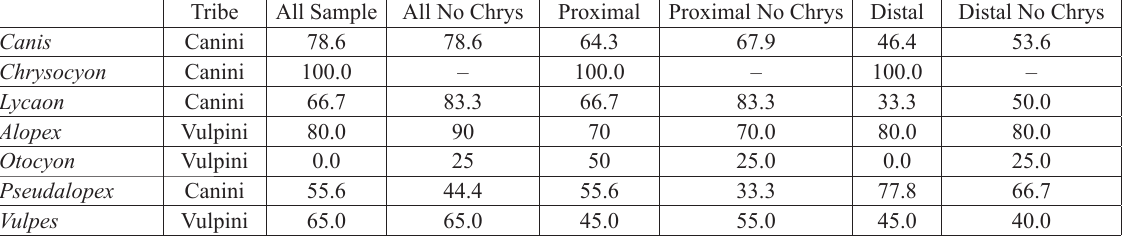
Table 4. Percentage of correctly classified cases after jack-knife analysis for Canidae genera as revealed by different samples. No Chrys, all species except